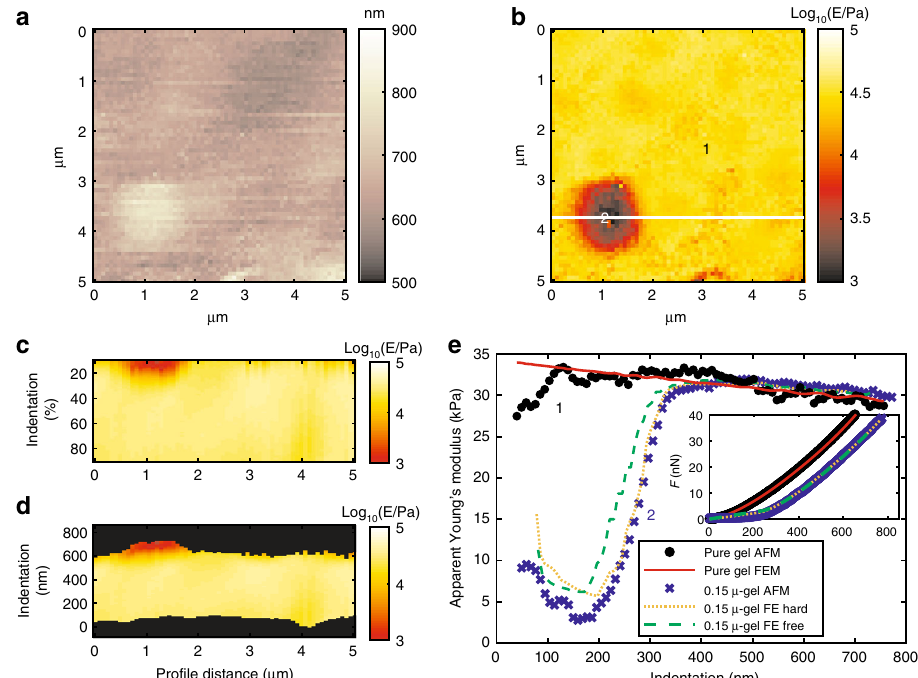
Fig. 2 Graphical results of mechanical analysis by AFMech Suite for 0.15 μ -gel. a Morphology map at zero force, vertical color bar represents height in nm. b Young ’ s modulus map in logarithmic scale at medium indentation (0 – 20% of maximum value). c Qualitative Young ’ s modulus tomography on relative indentation from white line in ( b ). d Qualitative Young ’ s modulus tomography on absolute indentation from line in ( b ). Vertical color bar for ( b – d ) represents logarithm base 10 of Young ’ s modulus in Pa. e Apparent Young ’ s modulus vs. indentation (inset: force vs. indentation) for points 1 and 2 of ( b ) comparing AFM results and FEM simulations for boundary conditions: no slip (FE hard) and free to slip (FE